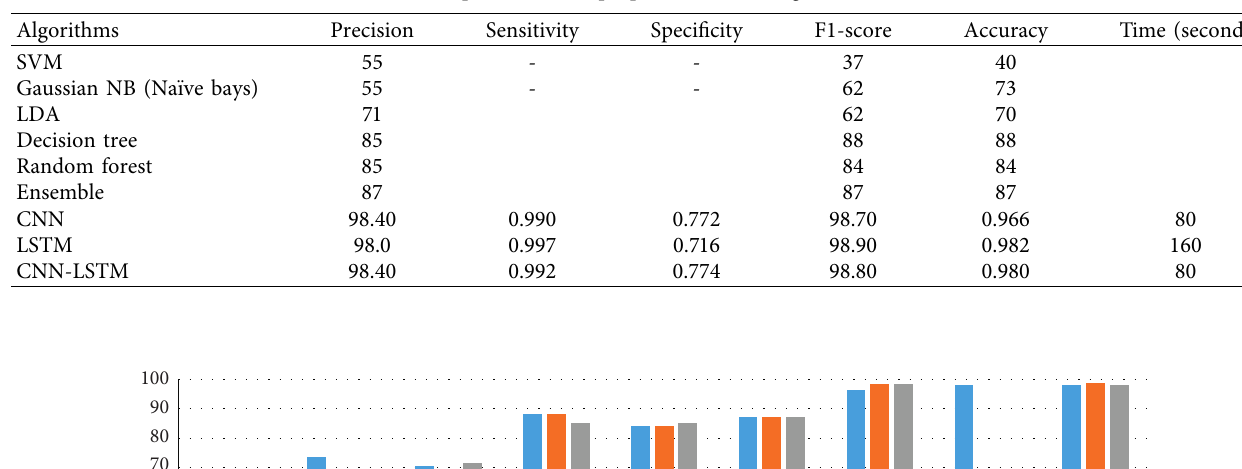
Table 9: Comparison of the proposed and existing model